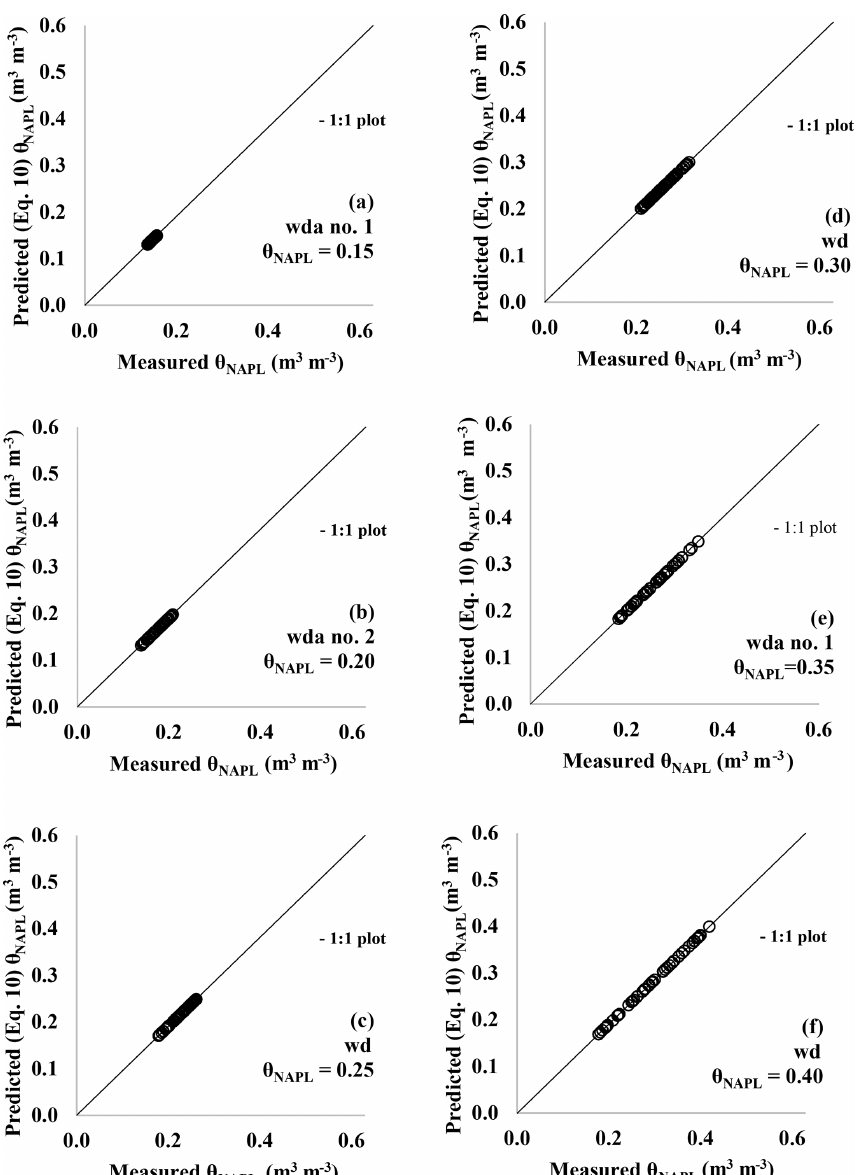
Figure 5. (a–f) Measured (Eq. 10) vs. known volumetric NAPL content ( θ NAPL ) of contaminated soils, with reference to the different remediation tests in Fig.